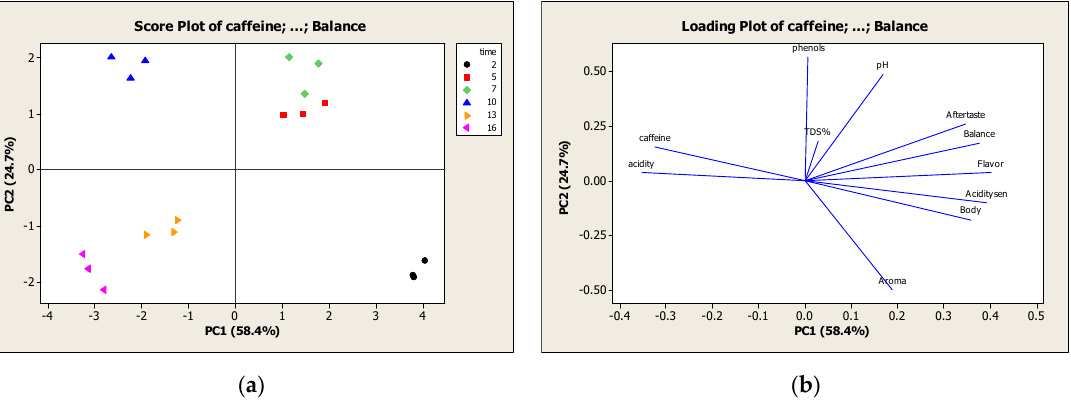
Figure 4. ( a ) Score plot of physicochemical and sensory properties in experiments with variation of vacuum cycles; ( b ) Loading plot of physicochemical and sensory properties in experiments with variation of vacuum cycles.